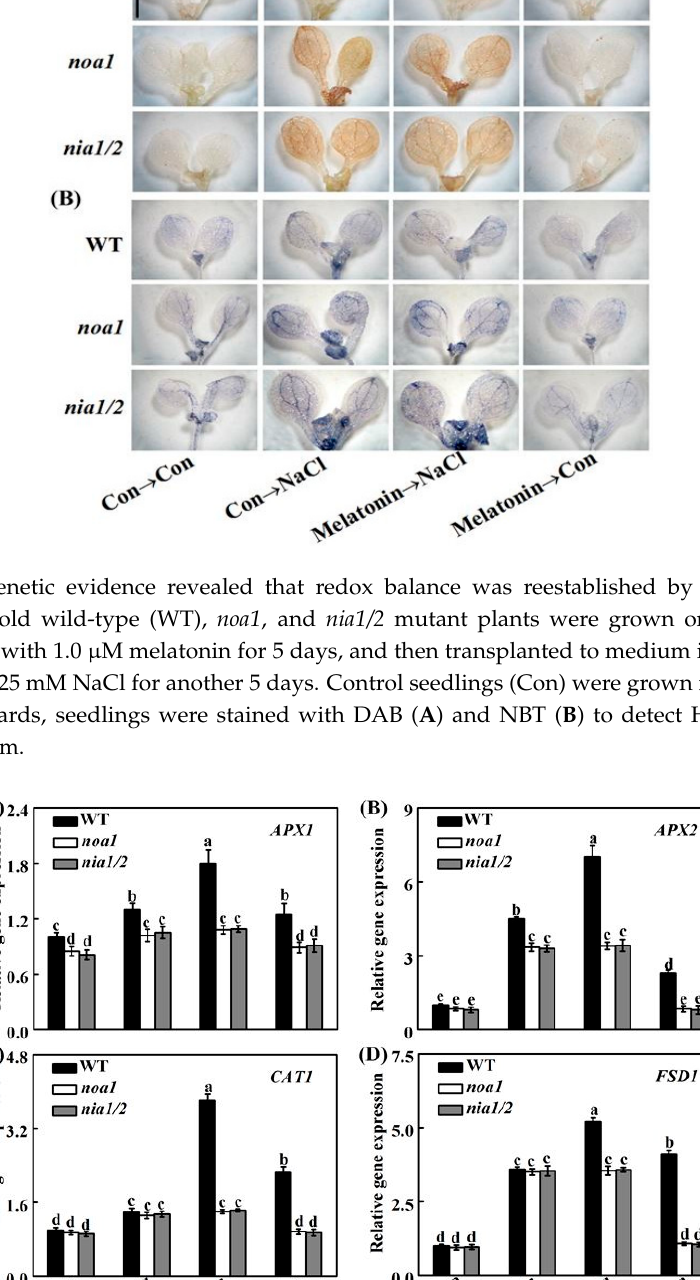
Figure 12. Changes in antioxidant gene expression. Five-day-old wild-type (WT), noa1 , and nia1/2 mutant plants were grown on MS medium supplemented with 1.0 μ M melatonin for 5 days, and then transplanted to medium in the presence or absence of 125 mM NaCl for another 24 h. The mRNA expression of APX1 ( A ), APX2 ( B ), CAT1 ( C ), and FSD1 ( D ) in root tissues were analyzed by qPCR. Control seedlings (Con) were grown in MS medium alone. Data are means ± SE of three independent experiments with at least three replicates for each. Bars with different letters are significant different at p < 0.05 according to Duncan’s multiple range